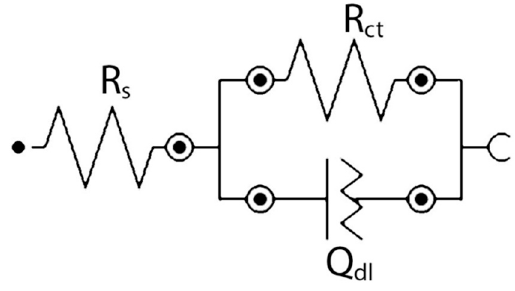
Figure 5. Equivalent circuit used to fit the electrochemical impedance spectroscopy (EIS) data.